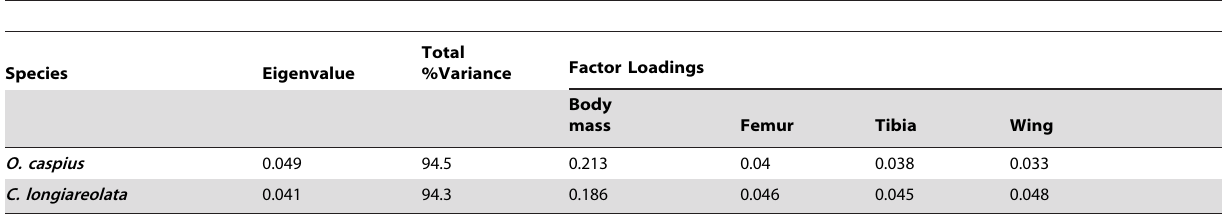
Table 3. Adult size variables summarized by Principal Components Analysis (PCA).